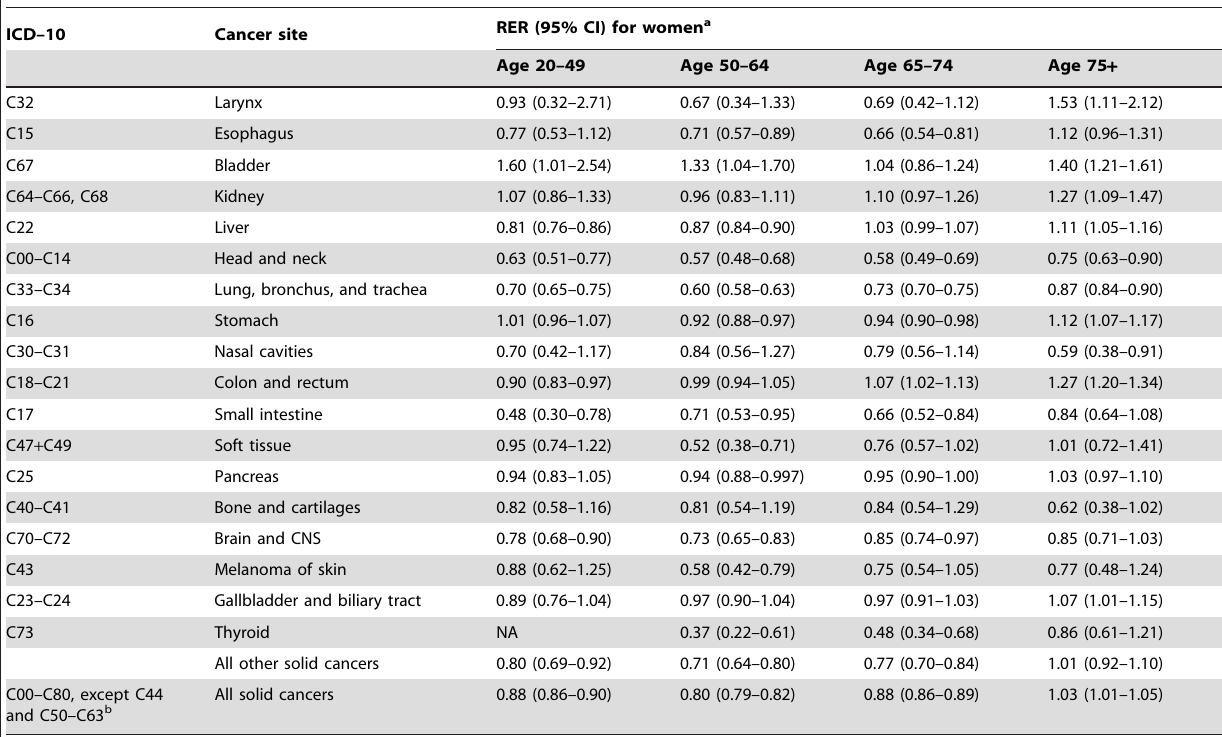
Table 3. Relative excess risk (RER) for solid cancer sites among Korean adults by age group,